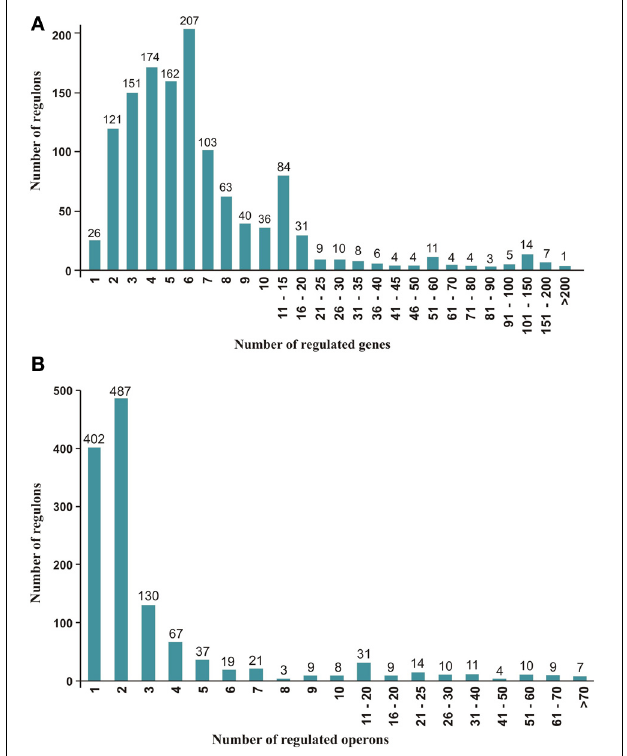
FIGURE 3 | Distribution of reconstructed LacI-TF regulons. (A) Distribution by the number of regulated genes. (B) Distribution by the number of operons.